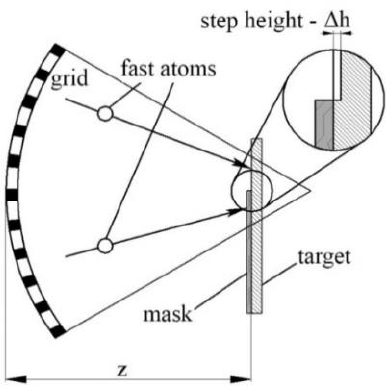
Figure 7. Schematic of the step formation on a target at the distance Z from the grid due to etching with fast argon atoms.